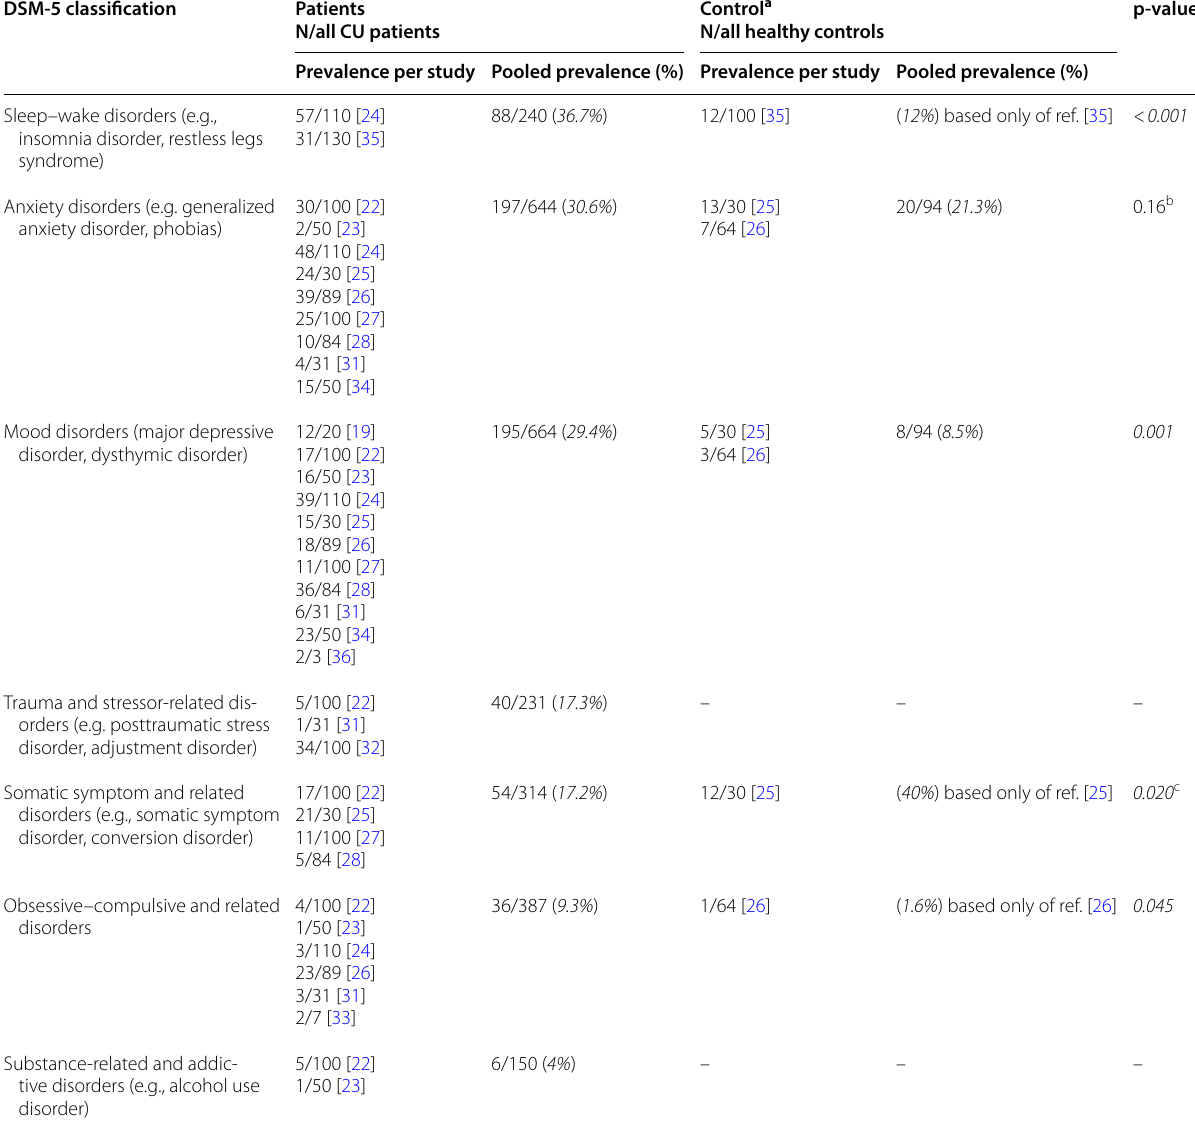
Table 4 Pooled prevalence of psychiatric disorders among chronic urticaria (CU) patients, categorized according to Diagnostic and Statistical Manual of Mental Disorders (DSM-5) (data listed for disorders referred in at least